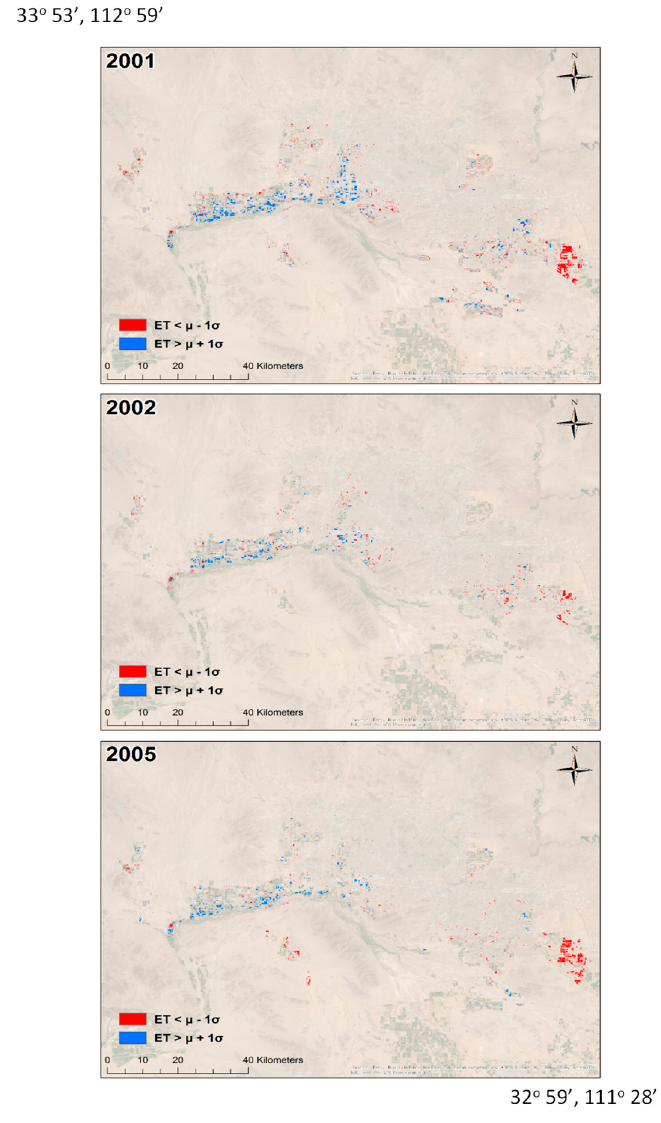
Figure 9. Excessive water consumption and considerably low water consumption areas for 2001, 2002, and 2005.